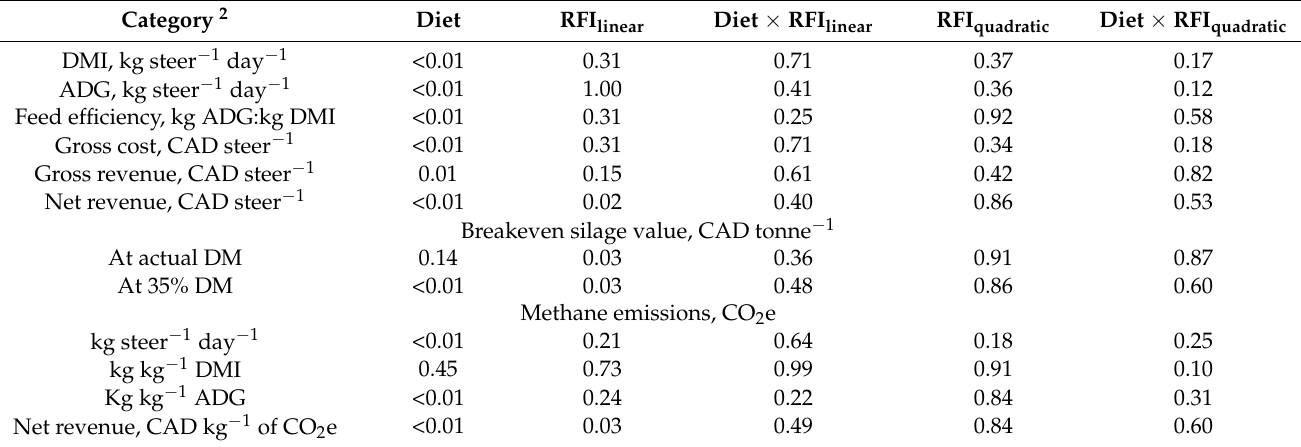
1 Fitted regression equations based on simplest model including all effects with p < 0.05 and preceding effects (i.e., if diet had a linear interaction with RFI, then diet and RFI linear effects would be included even if they had p > 0.05). 2 DMI, dry matter intake; ADG, average daily gain; DM, dry matter; CO 2 e, CO 2